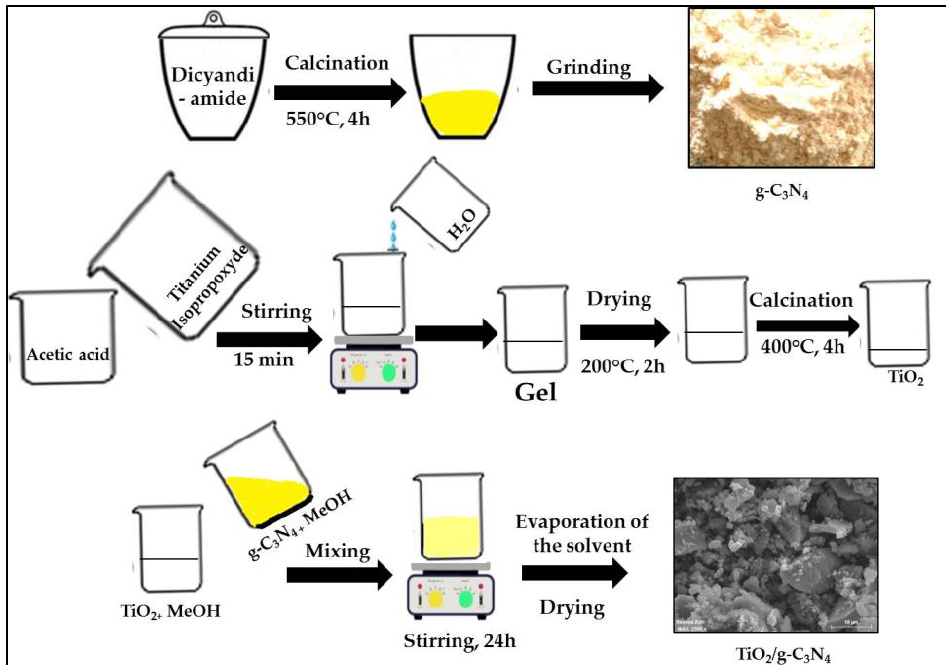
Figure 1. Schematic illustration of the preparation of materials.